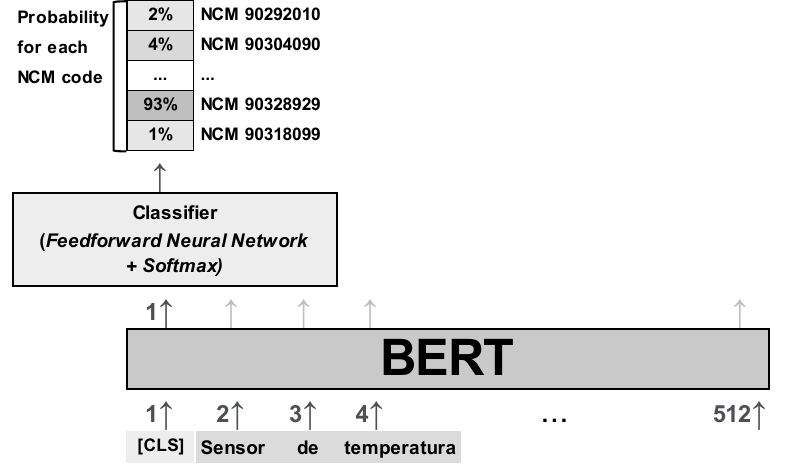
Figure 3. Fine-tuning process.